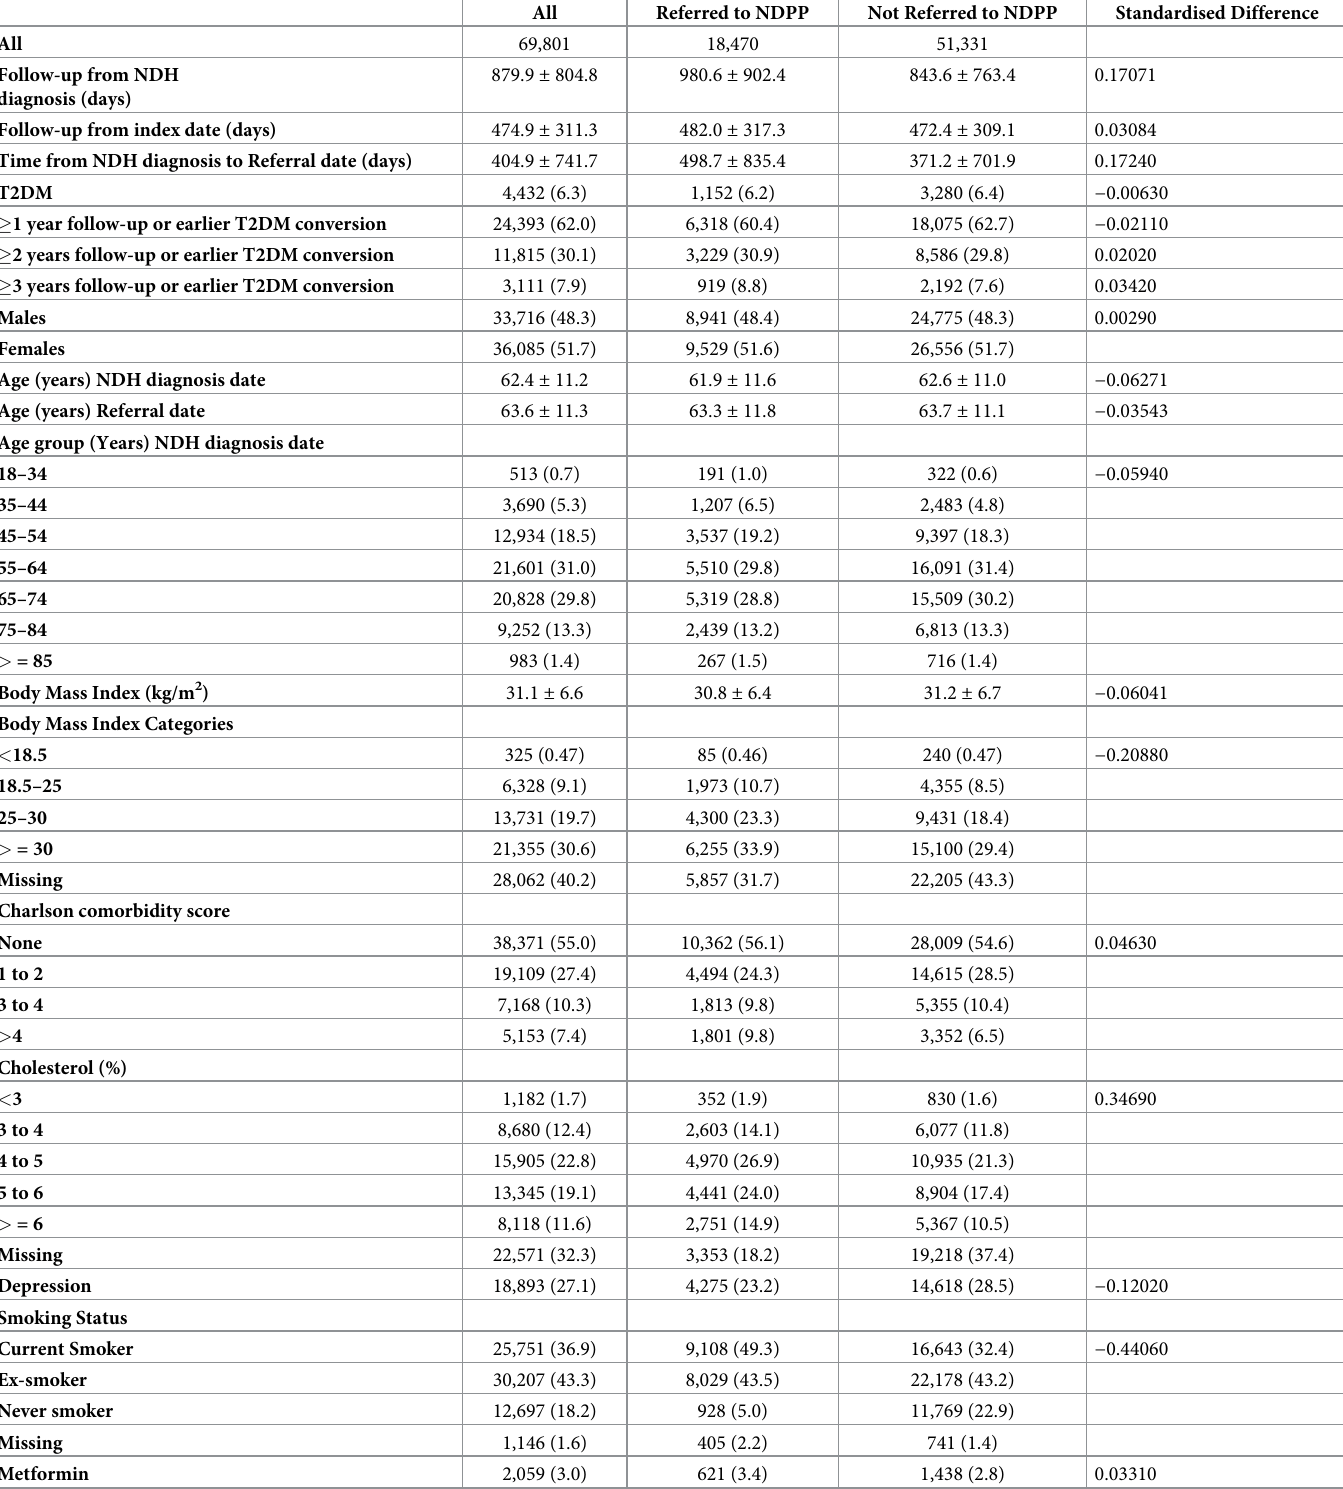
Table 1. Characteristics of the matched cohort, N (%) or mean ± standard deviation. [Cases are those referred to the NHS DPP and Controls are those with NDH diag- nosis in primary care, matched for sex and (within 3 years) age within 365 days of NDH diagnosis date]. All Referred to NDPP Not Referred to NDPP Standardised